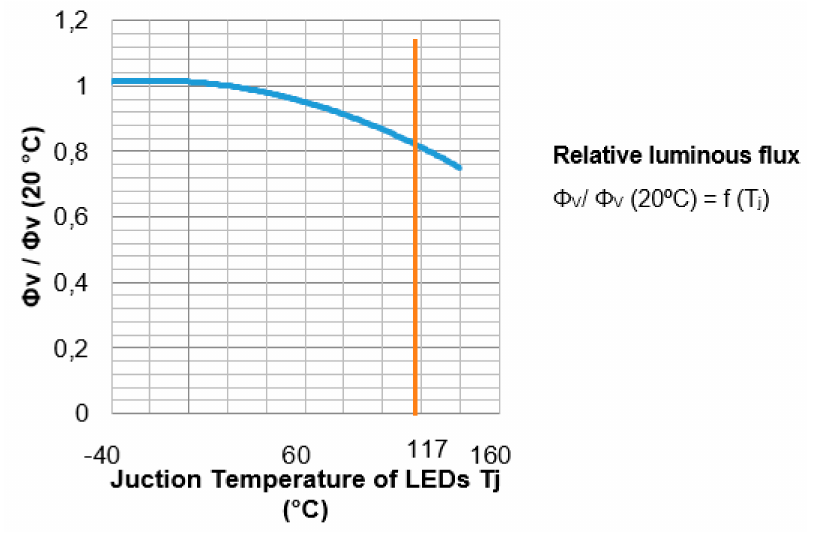
Figure 25. Junction temperature of LEDs (Tj) vs. luminous flux. Source: our own elaboration and data sheet LED Osram LUW CQAR (streetwhite).